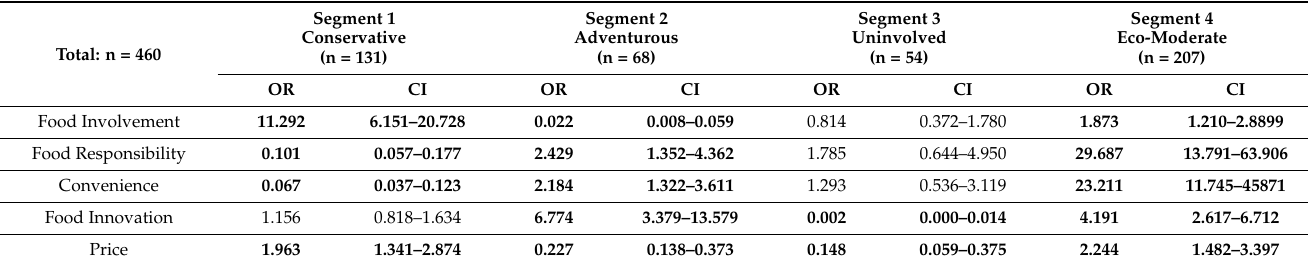
Table 2. Profiling of clusters by MFRL instruments a .